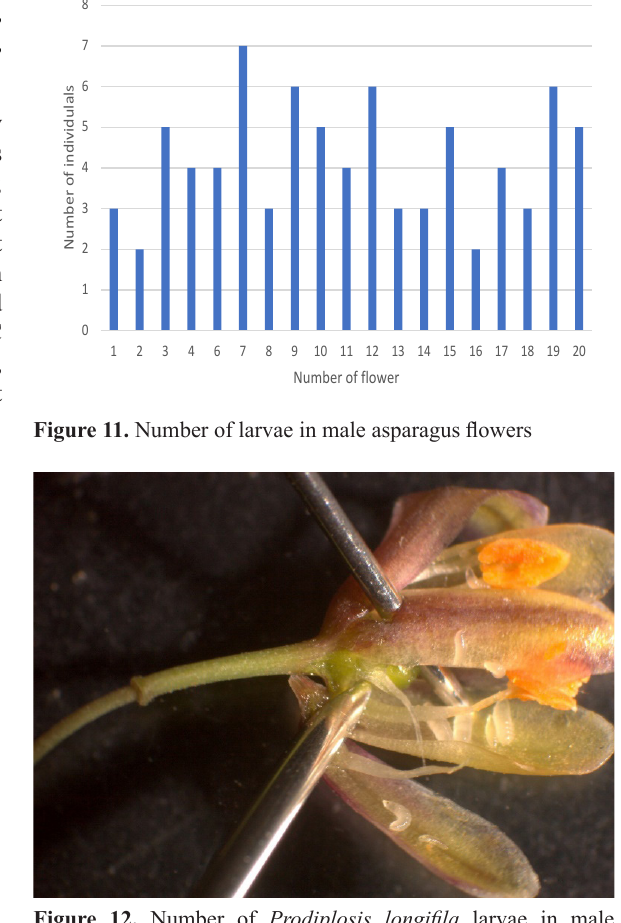
Figure 12. Number of Prodiplosis longifila larvae in male asparagus